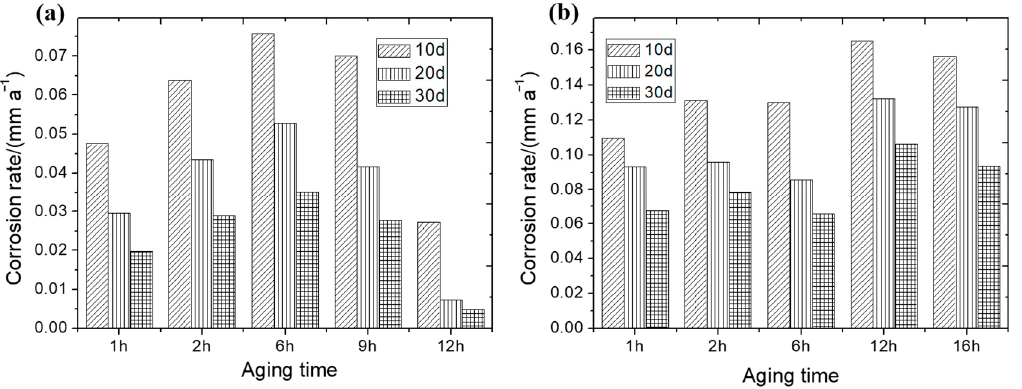
Figure 3. Immersion corrosion rates of ( a ) Al-7%Si-0.3%Mg-0.3%Cr alloy and ( b ) Al-7%Si-0.3%Mg- 0.3%Cr-1.5%Cu alloy alloys after di ff erent ageing